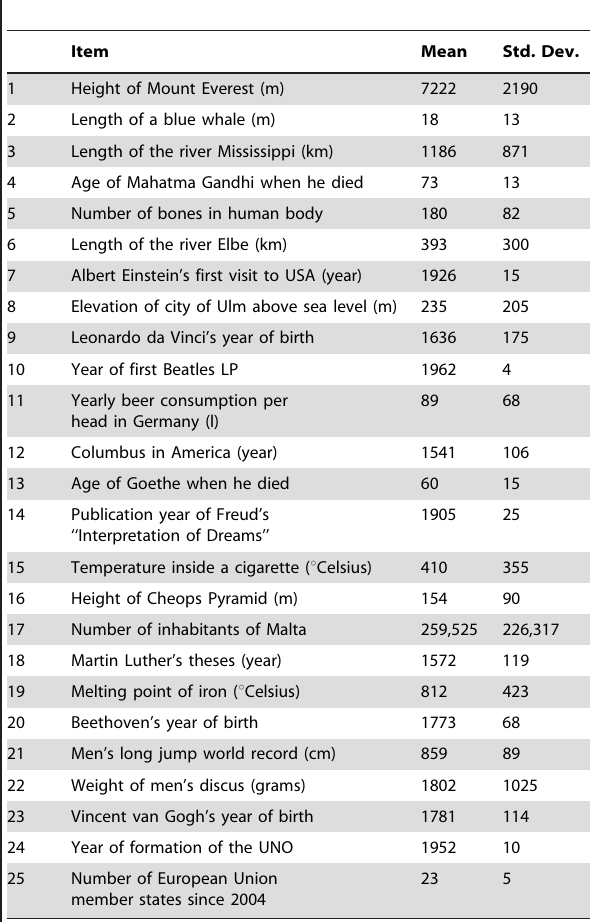
Table 1. Pilot study (N =45): Means and standard deviations of knowledge items.